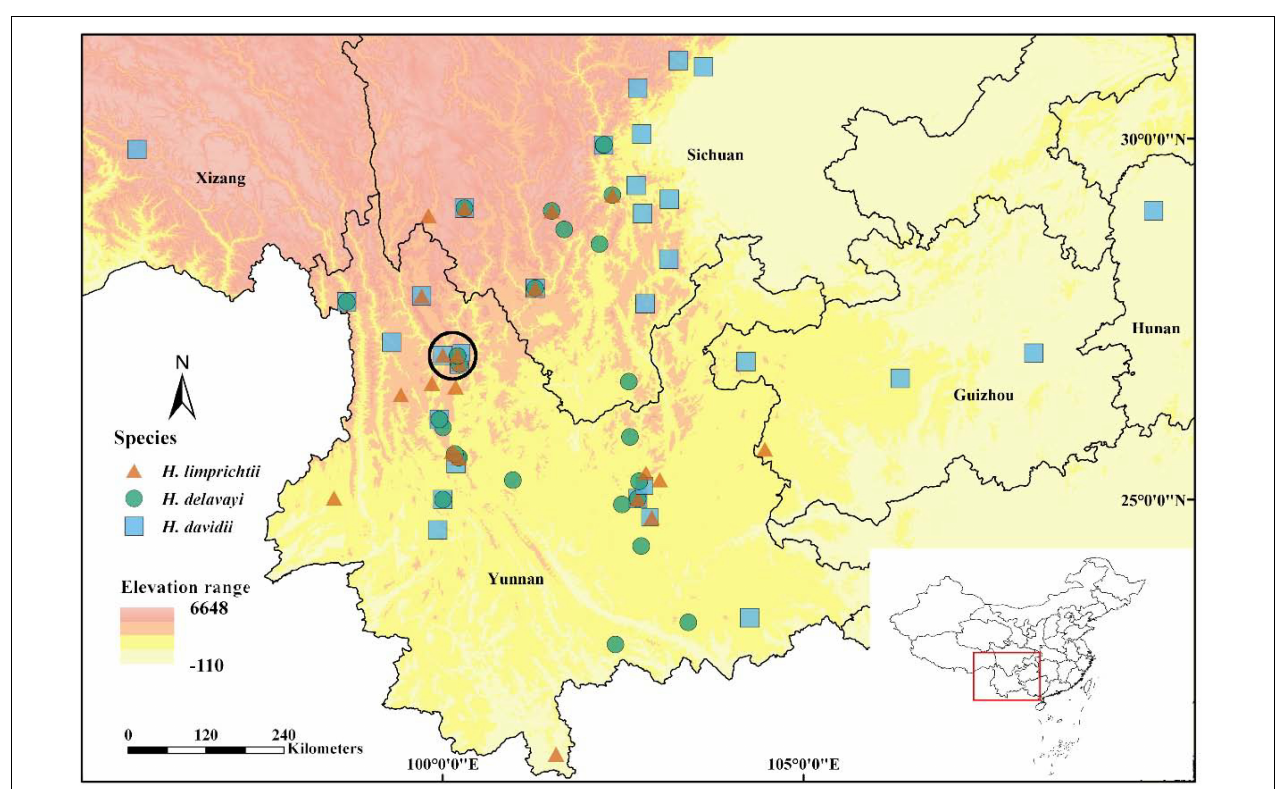
FIGURE 1 | Geographic ranges of three Habenaria species based on localities from herbarium collections, GBIF, and our own field survey from 2017 to 2021. The circled area (black circle) comprises the population sites used in our study in the surrounding of the city of Lijiang, northwestern Yunnan.